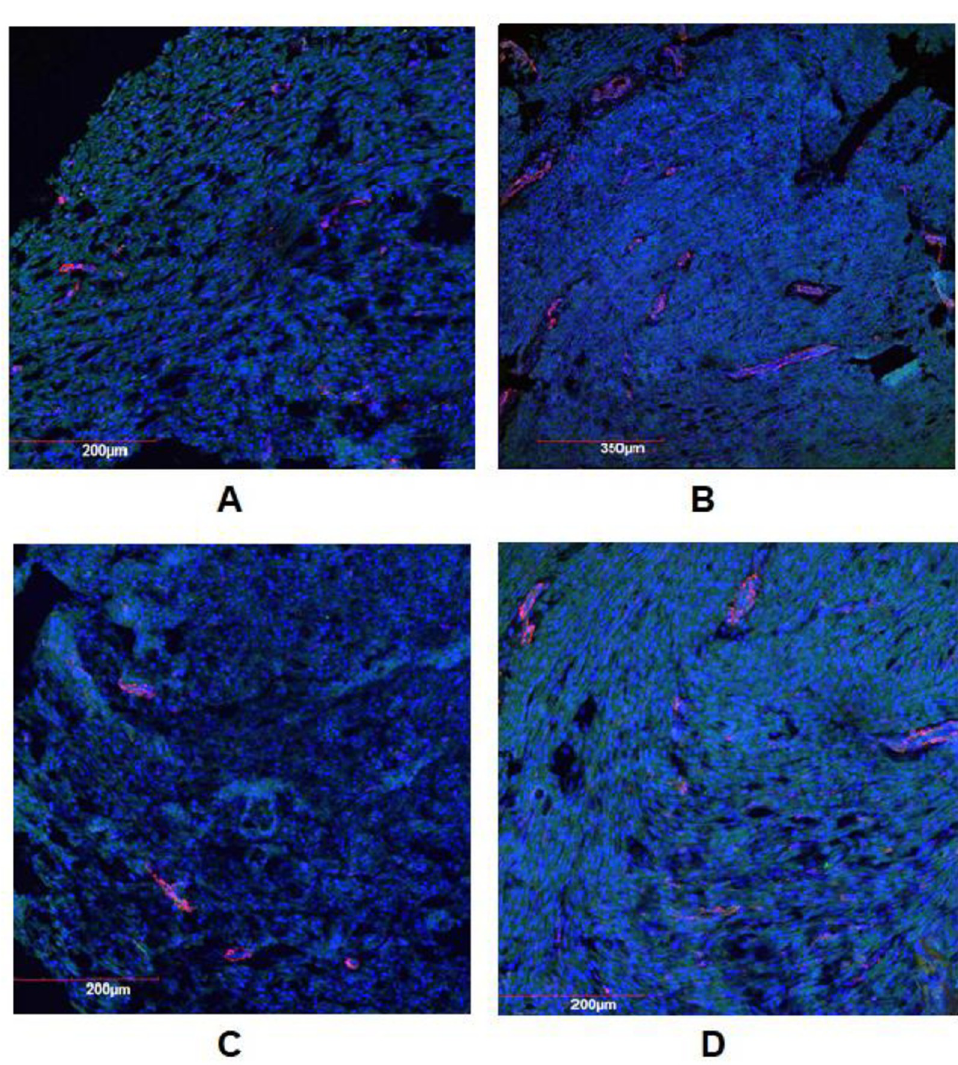
Fig 6. Expression of receptors for melatonin 1 (RMt1) and 2 (RMt2) in the heart, х 400. Immunofluorescent staining with antibodies to melatonin 1 and 2 receptors (red fluorescence), Hoechst nuclear stain (blue fluorescence), х 400. A— infants with SIDS, RMt1, B—the control group RMt1, C—infants with SIDS, RMt2, D—the control group